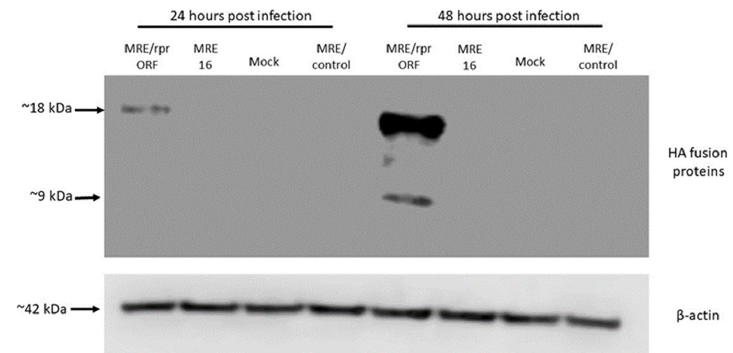
Figure 2. MRE/rprORF expresses the Reaper protein in infected cells. C6/36 cells were infected with MRE/rprORF, 5 ′ dsMRE16ic (labeled MRE16), or MRE/control, or were mock infected and protein was extracted at 24 and 48 hpi. Immunoblotting was done using antibodies against HA ( upper panel ) or β -actin as a loading control ( lower panel ).